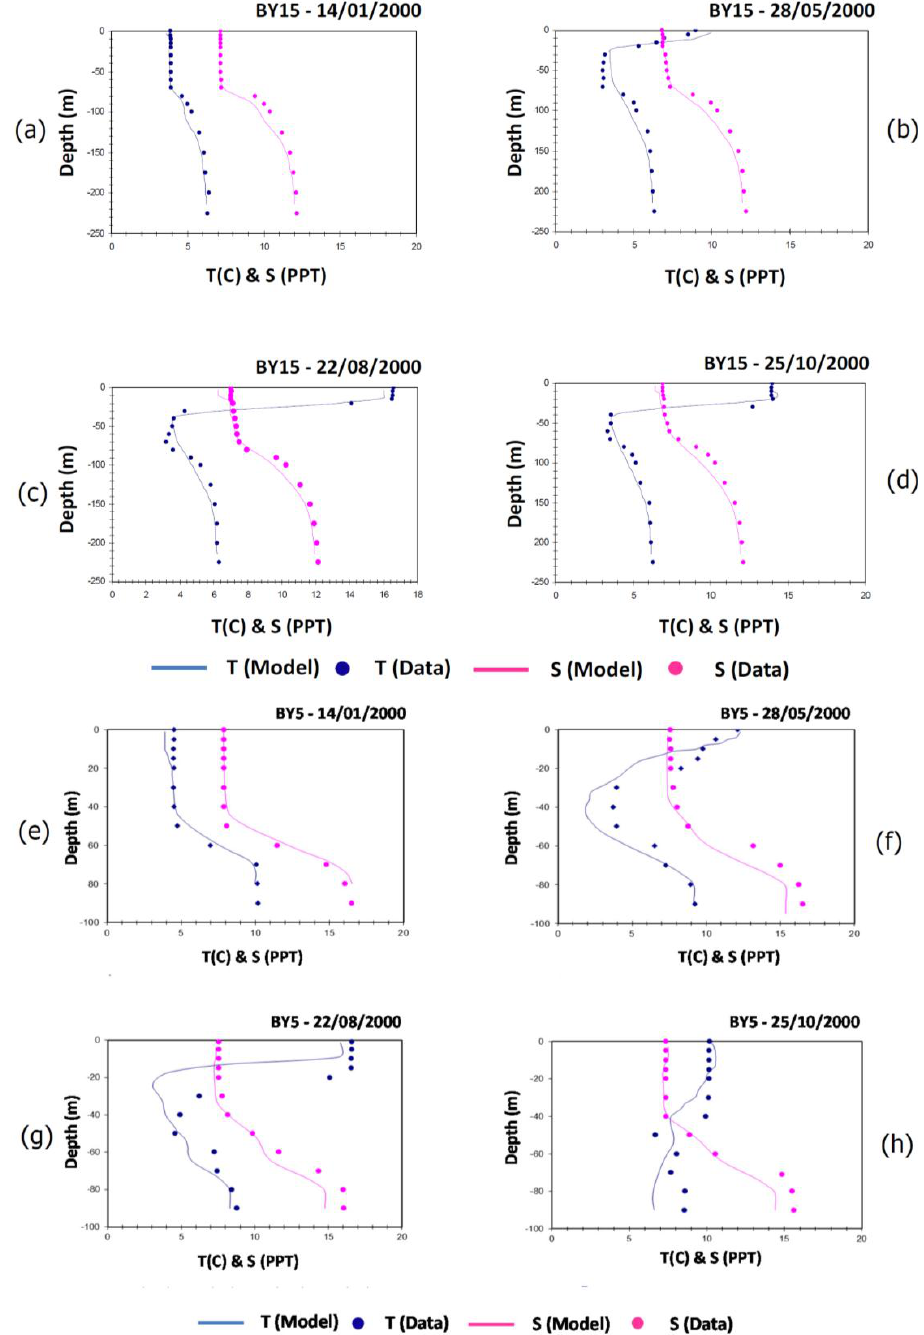
Figure 6. Comparison of model predicted vertical temperature and salinity profiles at the monitoring stations BY15 (Eastern Gotland Basin) and BY5 (Arkona Basin) with field measurements for the year 2000. ( a ) Station BY15—14/01/2000; ( b ) Station BY15—28/05/2000; ( c ) Station BY15—22/08/2000; ( d ) Station BY15—25/10/2000; ( e ) Station BY5—14/01/2000; ( f ) Station BY5—28/05/2000; ( g ) Station BY5—22/08/2000; ( h ) Station BY5—25/10/2000.